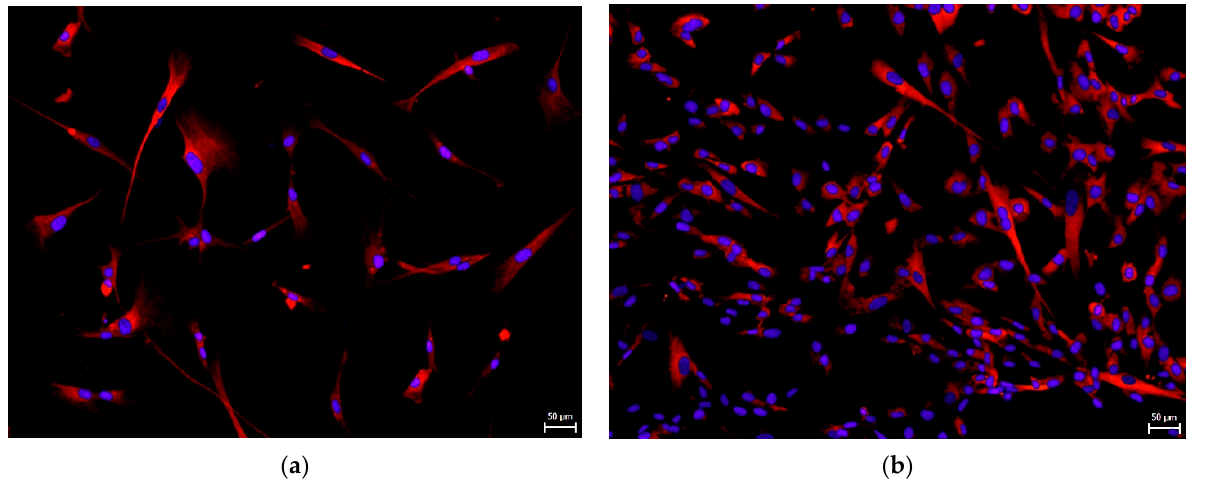
Figure 5. Immunocytochemical detection of Beta-3-tubulin, the early neuronal marker, in undiffer- entiated hNDP-SCs harvested in the 7th passage. Most cells were positive for Beta-3-tubulin (red fluorescence). Cell nuclei fluorescent blue. Scale bare 50 μ m: ( a ) hNDP-SCs cultivated in the FBS-culture medium; ( b ) hNDP-SCs cultivated in the hPL-culture medium.